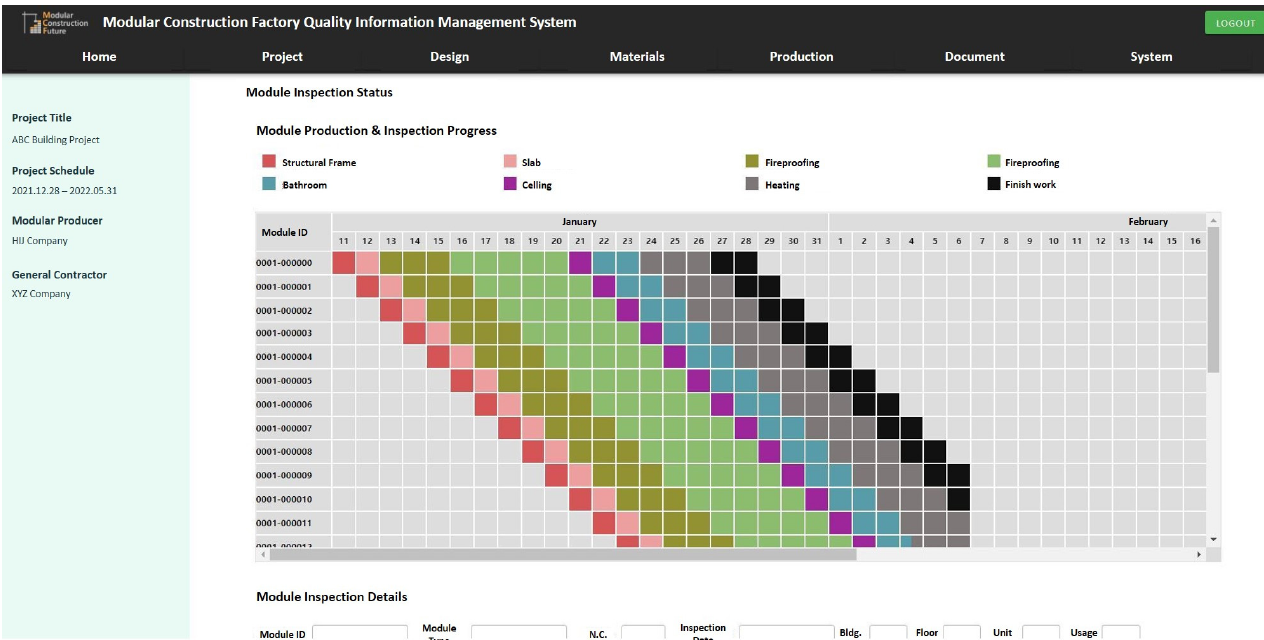
Figure 10. Information management in the production inspection status.